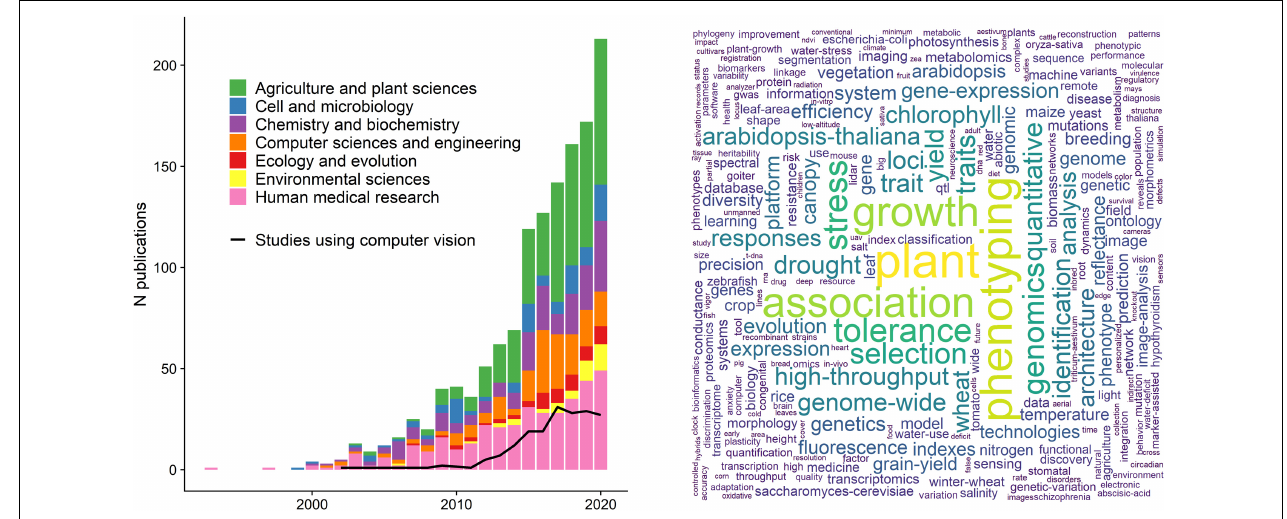
FIGURE 1 | The current state of phenomics research. Left panel: a literature survey using the search key “phenomic*” in a Web of Science topic search (title, keywords, abstract) resulted in 1,408 papers (01/03/2021). Here we show only papers published between 1990 and before 2021 (1,343 papers) for better visual inference. Traditionally, phenomics approaches are used in agricultural sciences and crop research to maximize yield, as well as in human medicine to study drug responses and disorder phenotypes. The black line denotes the studies that used computer vision or some sort of image analysis (acquired with a topic search among the retrieved papers using the strings “computer vision,” “image analysis,” “image based,” “image processing”), indicating that only a small subset of the studies uses image analysis. Right panel: a word cloud that was constructed using the 500 most used keywords from the papers presented in the left